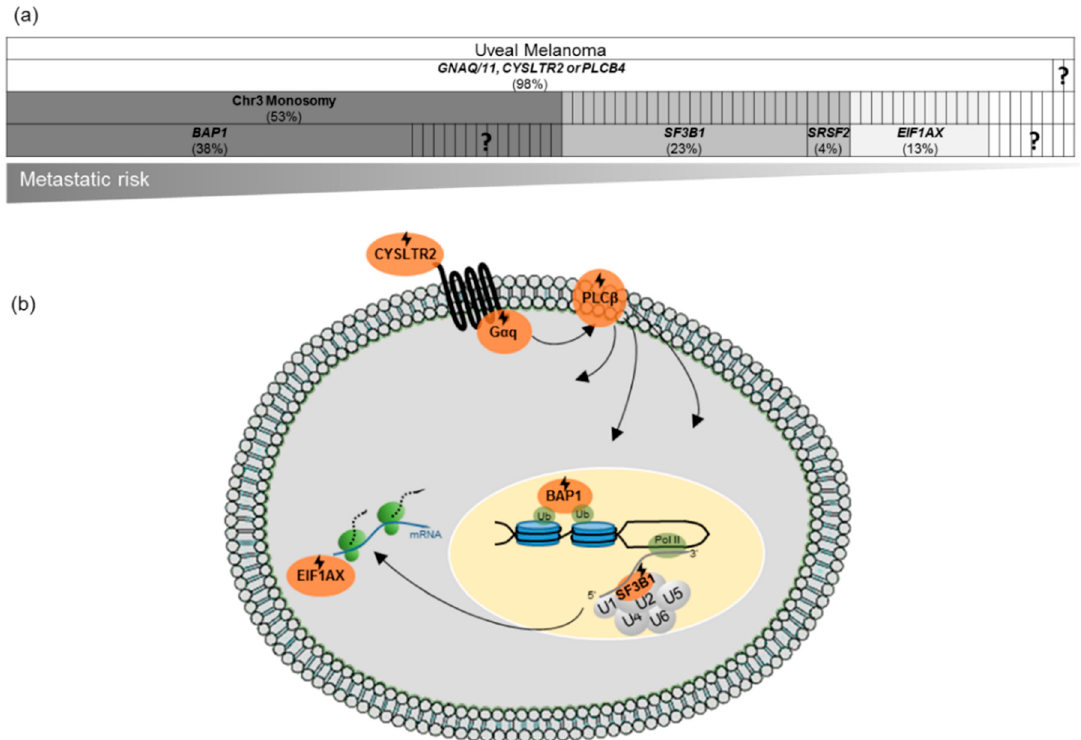
Figure 1. Genomic and genetic alterations in uveal melanoma (UM) and the affected biological processes. ( a ). Frequency of mutations in UM and the associated prognostic value: BRCA1 associated protein 1 ( BAP1) mutations are mostly associated with chromosome 3 monosomy and an early metastatic risk (~5 years after primary UM diagnosis), splicing factor 3b subunit 1 ( SF3B1 ) and serine/arginine-rich splicing factor 2 ( SRSF2 ) mutations are mainly associated with chromosome 3 disomy and a late-onset metastatic risk (~8 years after primary UM diagnosis), while eukaryotic translation initiation factor 1A X-linked ( EIF1AX ) mutations are associated with chromosome 3 disomy and a low risk of metastasis. Data is retrieved from The Cancer Genome Atlas (TCGA) UM dataset (cBioportal for Cancer Genomics) [56,57]. ( b ). Main biological processes impacted by the recurrent mutations in UM. Mutations in components of G protein-coupled receptors (GPCRs) lead to the constitutive activation of G α q signaling and several downstream pathways. Further oncogenic events include mutations in BAP1 , SF3B1/SRSF2 , or EIF1AX , involved in chromatin modulation, splicing, and translation initiation, respectively. Mutations are indicated by